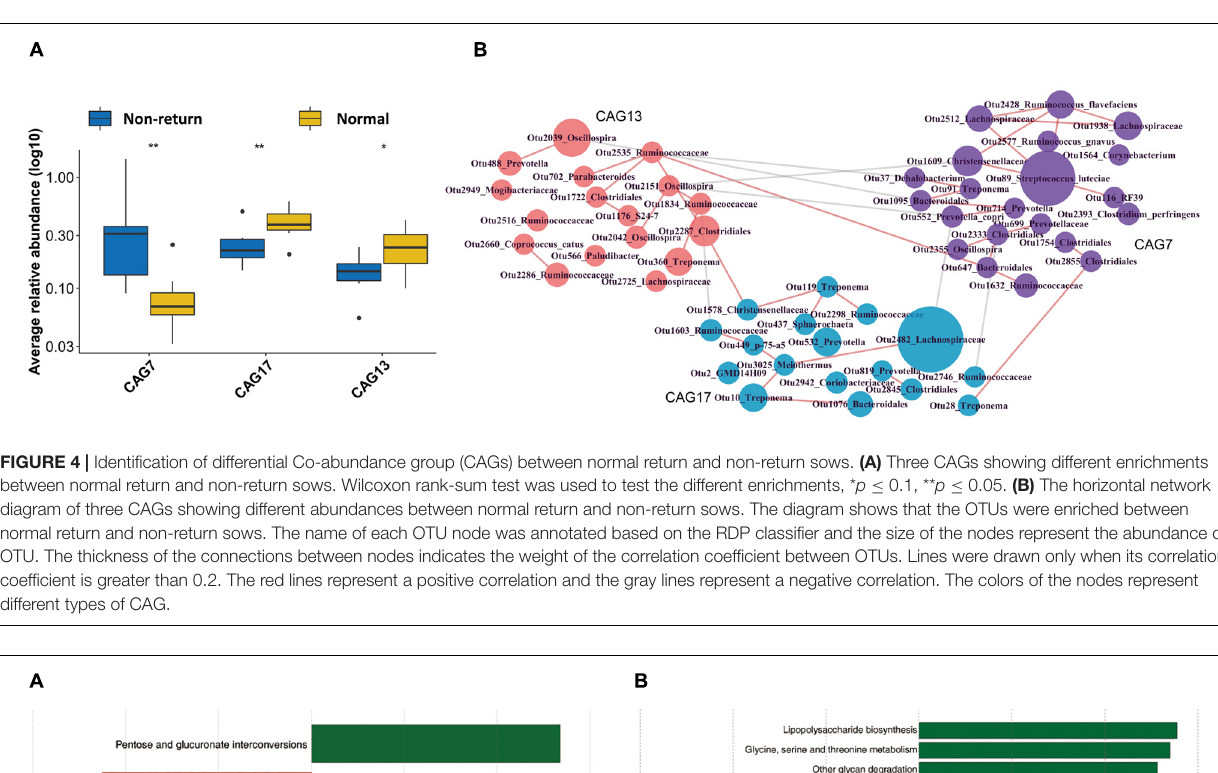
vaginal microbiota between two groups of sows ( p = 0.02 and 0.03) ( Supplementary Figure 3B